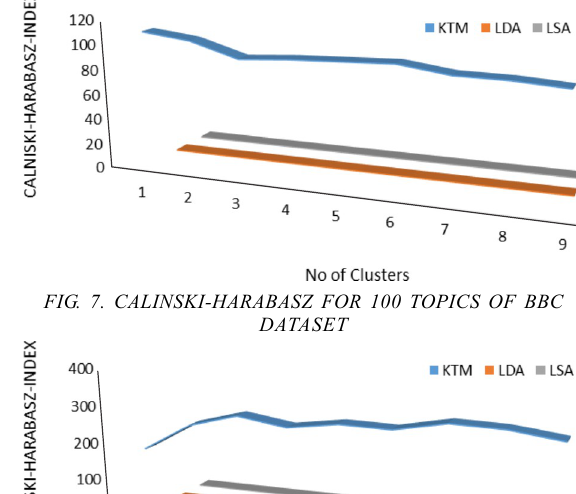
FIG. 5. CALINSKI-HARABASZ FOR 50 TOPICS OF BBC DATASET